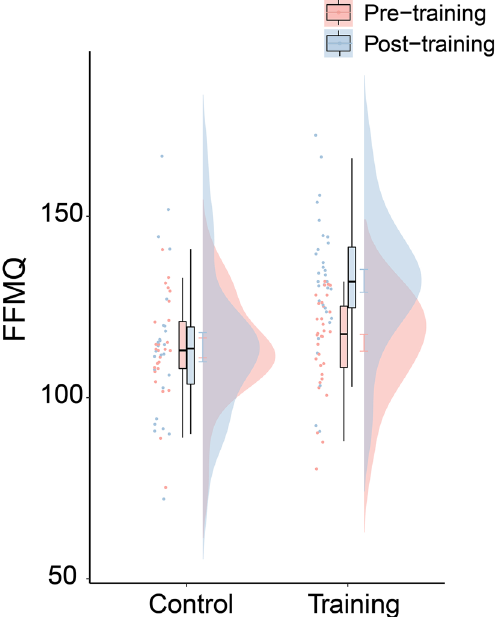
Figure 2. Trait mindfulness (FFMQ) depicted as a function of Group and Experimental Session. Error bars on the distribution plots display standard errors of the means. Boxes display the interquartile range (IQR) between the 25th and 75th percentile. Horizontal lines inside the boxes indicate the